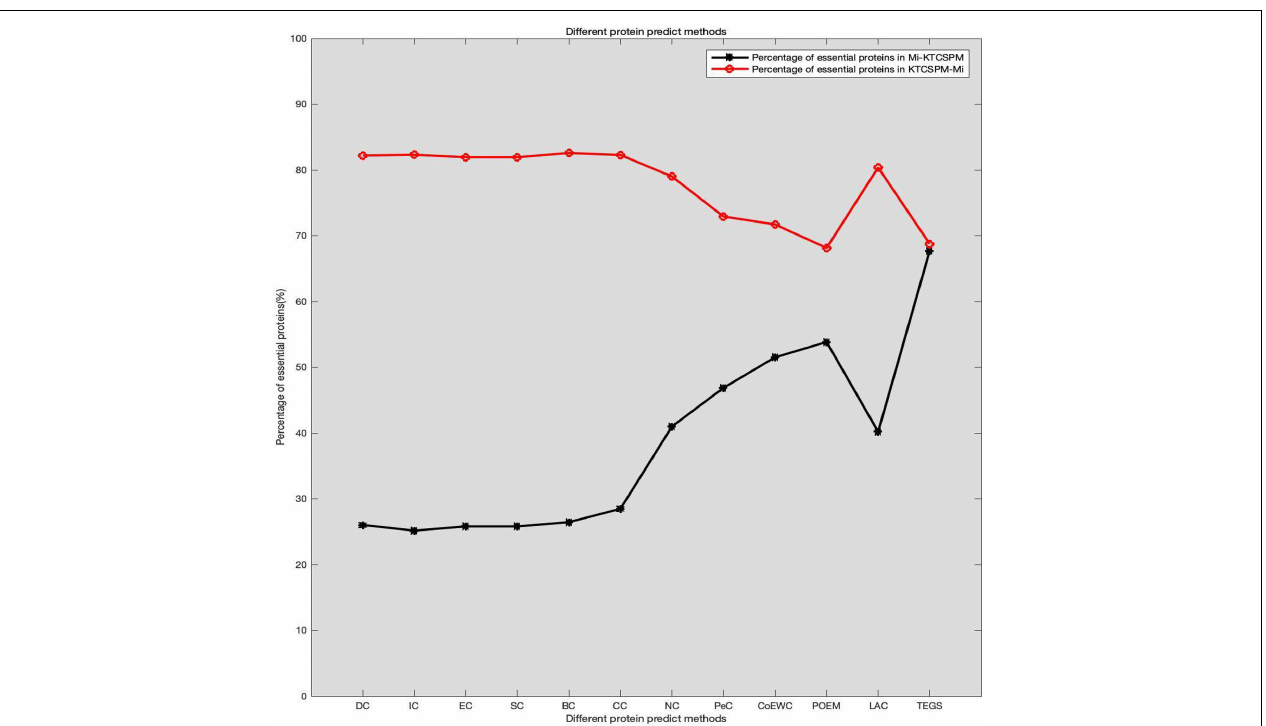
FIGURE 6 | Comparison results between KTCSPM and 12 competing methods, where the X axis denotes the competing methods including DC, IC, EC, SC, BC, CC, NC, PEC, COEWC, POEM, LAC, TEGS, and the Y axis represents the proportion of true essential proteins predicted by each method.